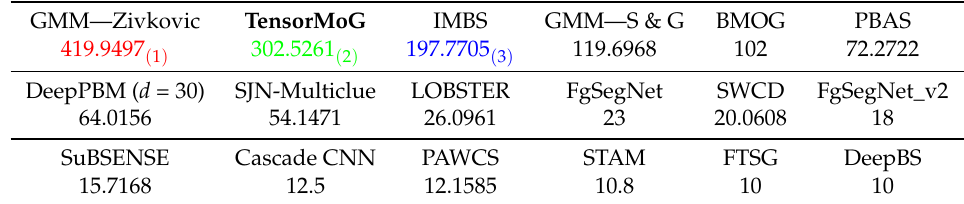
Table 8. Processing speed evaluation among methods regarding resolution 320 × 240 (unit: fps—frames per second, higher is